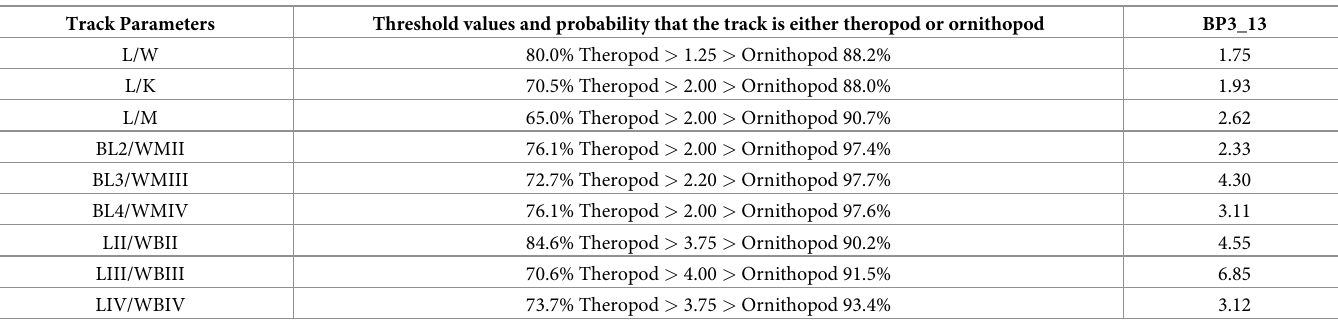
Table 8. Assessment of the trackmaker affinity of